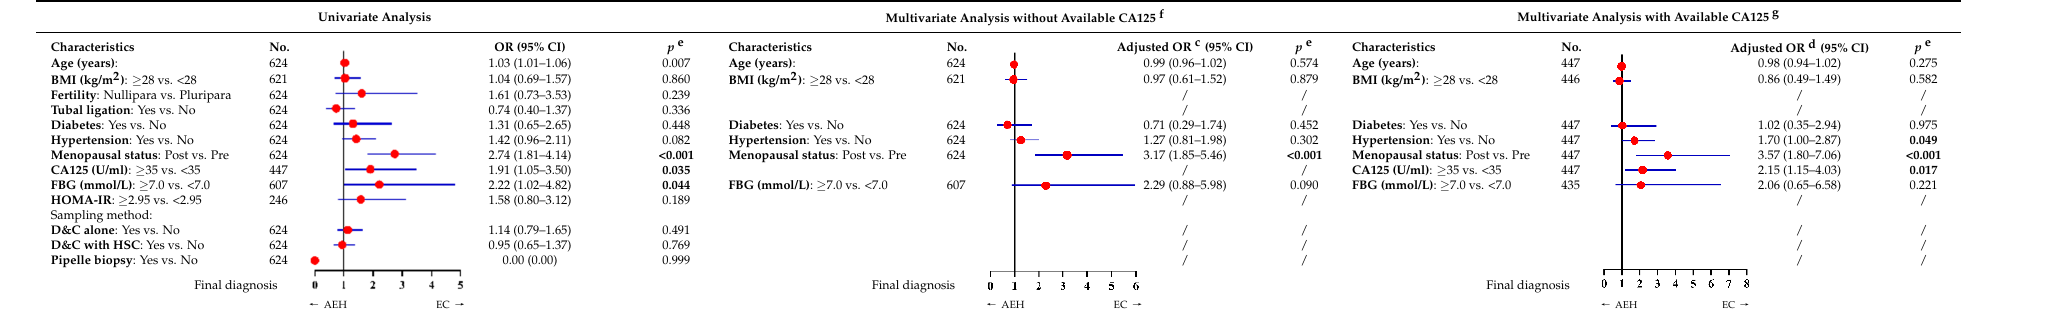
EC → a In total of 624 patients with available data. b In total of 447 patients who had serum CA125 value with available data. c OR adjusted for age, BMI, diabetes, a In total of 624 patients with available data. b In total of 447 patients who had serum CA125 value with available data. c OR adjusted for age, BMI, diabetes, hypertension and FBG level. hypertension and FBG level. d OR adjusted for age, BMI, diabetes and FBG level. e Significant difference p < 0.05. Notes: f CA125 was not included into this a In total of 624 patients with available data. b In total of 447 patients who had serum CA125 value with available data. c OR adjusted for age, BMI, diabetes, hypertension d OR adjusted for age, BMI, diabetes and FBG level. e Significant difference p < 0.05. Notes: f CA125 was not included into this analysis for only 447 of 624 preoperative-AEH patients and FBG level. d OR adjusted for age, BMI, diabetes and FBG level. e Significant difference p < 0.05. Notes: f CA125 was not included into this analysis for only 447 of 624 analysis for only 447 of 624 preoperative-AEH patients had available serum CA125 value. g This analysis was performed in 447 of 624 preoperative-AEH patients had available serum CA125 value. g This analysis was performed in 447 of 624 preoperative-AEH patients with available serum CA125 value. Abbreviations: AEH, atypical endometrial preoperative-AEH patients had available serum CA125 value. g This analysis was performed in 447 of 624 preoperative-AEH patients with available serum CA125 value. with available serum CA125 value. Abbreviations: AEH, atypical endometrial hyperplasia; EC, endometrial cancer; OR, odds ratio; CI, confidence interval; BMI, hyperplasia; EC, endometrial cancer; OR, odds ratio; CI, confidence interval; BMI, body mass index; CA125, cancer antigen 125; FBG, fasting blood glucose; HOMA-IR, homeostasis body mass index; CA125, cancer antigen 125; FBG, fasting blood glucose; HOMA-IR, homeostasis model assessment—insulin resistance; D&C, dilatation and model assessment—insulin resistance; D&C, dilatation and curettage; HSC, hysteroscopy. curettage; HSC, hysteroscopy. Table 3. Univariate and multivariate analyses of factors related to concurrently intermediate-high-risk EC in 190 final-EC patients a and in 130 final-EC patients b with Table 3. Univariate and multivariate analyses of factors related to concurrently intermediate-high-risk EC in 190 final-EC patients a and in 130 final-EC patients b available serum CA125 value according to logistic regression model. with available serum CA125 value according to logistic regression model. Table 3. Univariate and multivariate analyses of factors related to concurrently intermediate-high-risk EC in 190 final-EC patients a and in 130 final-EC patients b Table 3. Univariate and multivariate analyses of factors related to concurrently intermediate-high-risk EC in 190 final-EC patients a and in 130 final-EC patients b Table 3. Univariate and multivariate analyses of factors related to concurrently intermediate-high-risk EC in 190 final-EC patients a and in 130 final-EC patients b Multivariate analysis with available CA125 g with available serum CA125 value according to logistic regression model. with available serum CA125 value according to logistic regression model. with available serum CA125 value according to logistic regression model. Characteristics Table 3. Univariate and multivariate analyses of factors related to concurrently intermediate-high-risk EC in 190 final-EC patients a and in 130 final-EC patients b with Table 3. Univariate and multivariate analyses of factors related to concurrently intermediate-high-risk EC in 190 final-EC patients a and in 130 final-EC patients b with Table 3. Univariate and multivariate analyses of factors related to concurrently intermediate-high-risk EC in 190 final-EC patients a and in 130 final-EC patients b with Univariate Analysis Multivariate Analysis without Available CA125 f Multivariate analysis with available CA125 g Univariate Analysis Multivariate Analysis without Available CA125 f Multivariate analysis with available CA125 g Univariate Analysis Multivariate Analysis without Available CA125 f Multivariate analysis with available CA125 g available serum CA125 value according to logistic regression model. available serum CA125 value according to logistic regression model. available serum CA125 value according to logistic regression model. Characteristics No. Characteristics No. OR (95% CI) p e Characteristics Characteristics Characteristics Univariate Analysis Multivariate analysis without available CA125 f Multivariate analysis with available CA125 g Univariate Analysis Multivariate analysis without available CA125 f Multivariate analysis with available CA125 g Univariate Analysis Multivariate analysis without available CA125 f Multivariate analysis with available CA125 g Characteristics No. Characteristics No. OR (95% CI) p e Characteristics Characteristics No.